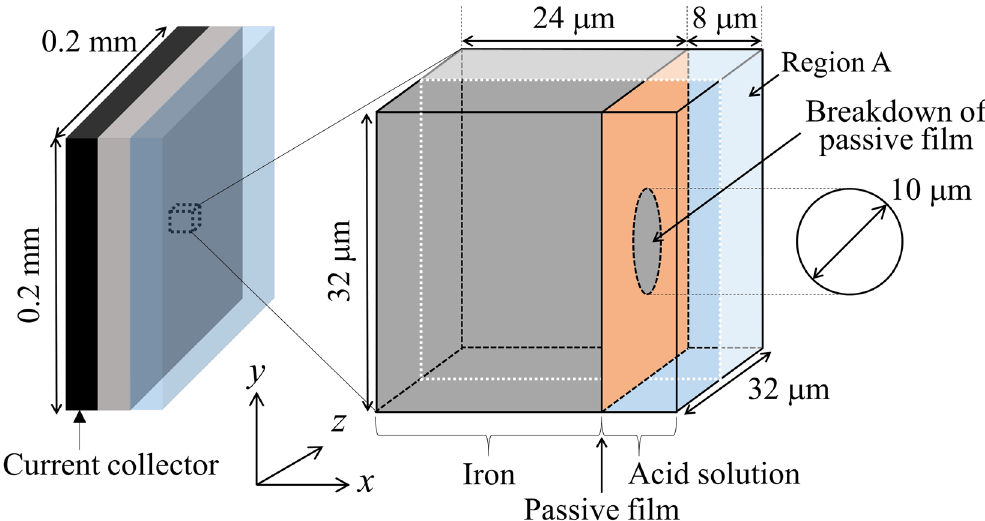
Figure 5. Simulation model used to simulate the pitting corrosion on a pure iron surface covered by a passive